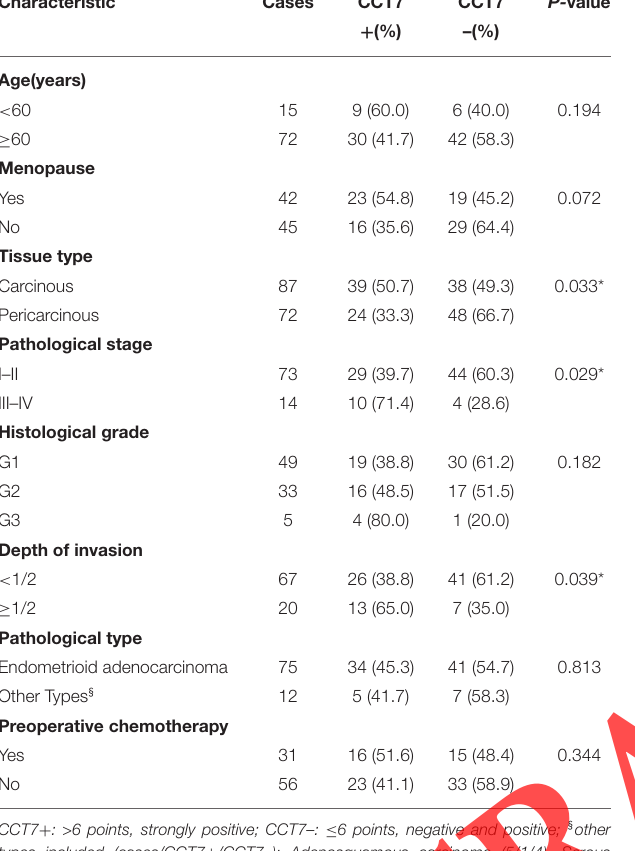
TABLE 1 | Correlations between CCT7 and clinicopathological features in patients with endometrial cancer.